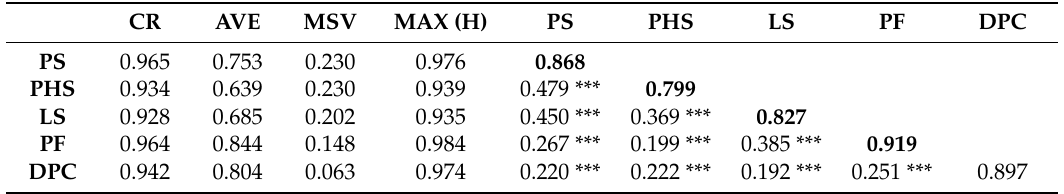
Table 5. Composite reliability, convergent, and discriminant validity.